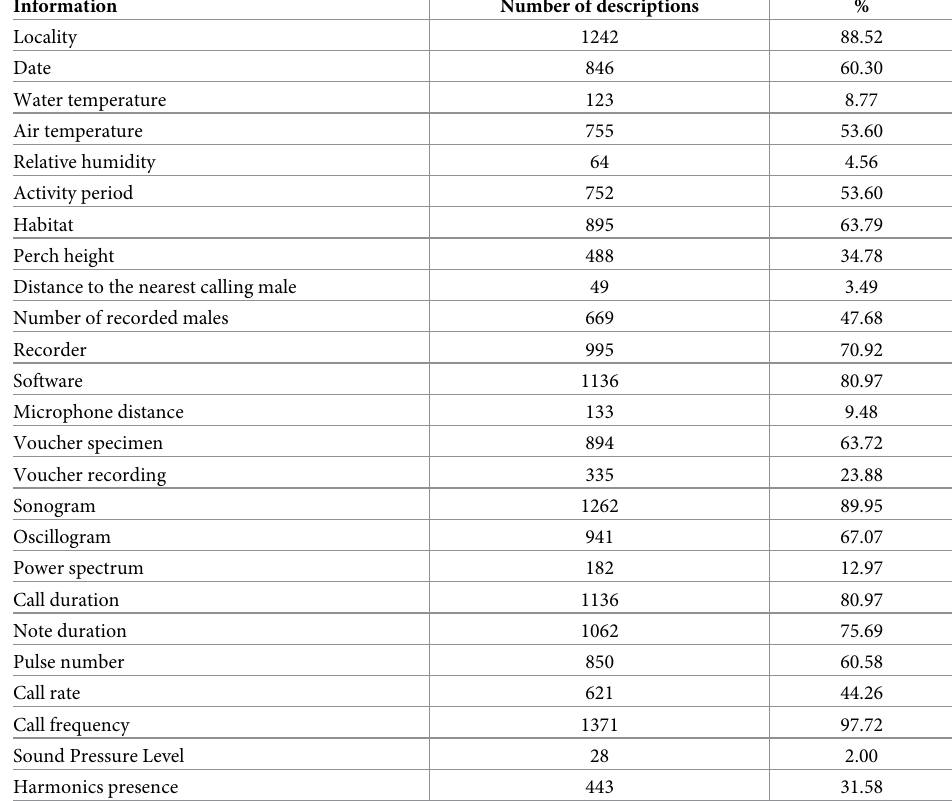
Table 1. Metadata variables shown in the 1,403 descriptions of advertisement calls of Brazilian anuran